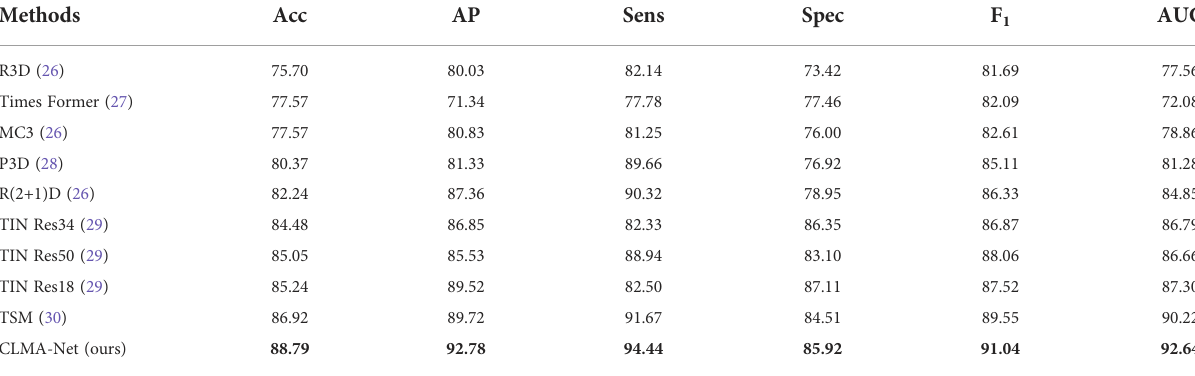
TABLE 4 Quantitative comparisons of our network and compared methods on the collected ultrasound sequence dataset.